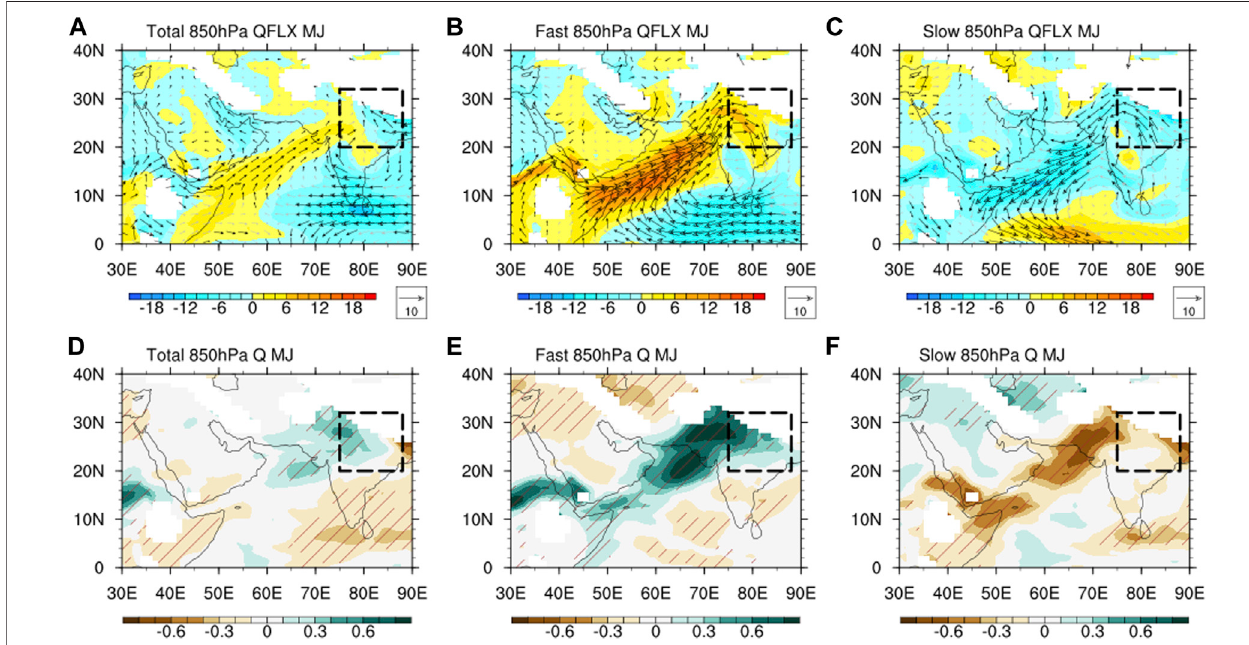
FIGURE10| Thetotal[ (A,D) ,CMD − CMN],fast[ (B,E) ,UMD − UMN]andslow[ (C,F) (CMD − CMN) − (UMD − UMN)]responsesofmoisture fl ux[ A – C ;g/(hPam s)]and speci fi chumidity (D – F, g/kg)at850 hPatothedustDREduringtheearlymonsoonseason(May – June).Black(grey)arrowsrepresentthemoisture fl uxvectordifferences statistically signi fi cant (insigni fi cant) at the 0.1 level. Brown lines represent the values statistically signi fi cant at the 0.1 level.